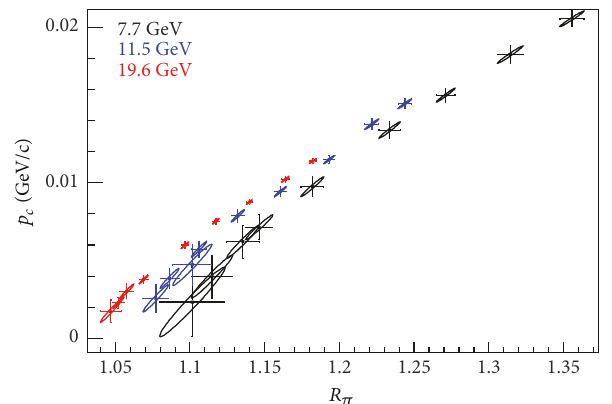
Figure 4: Contours in the 𝑝 𝑐 - 𝑅 𝜋 plane showing 1 - 𝜎 deviation lines from the minimum 𝜒 2 values, as well as the values of the fit parameters 𝑝 𝑅 𝑐 and 𝜋 (corresponding to the minimum